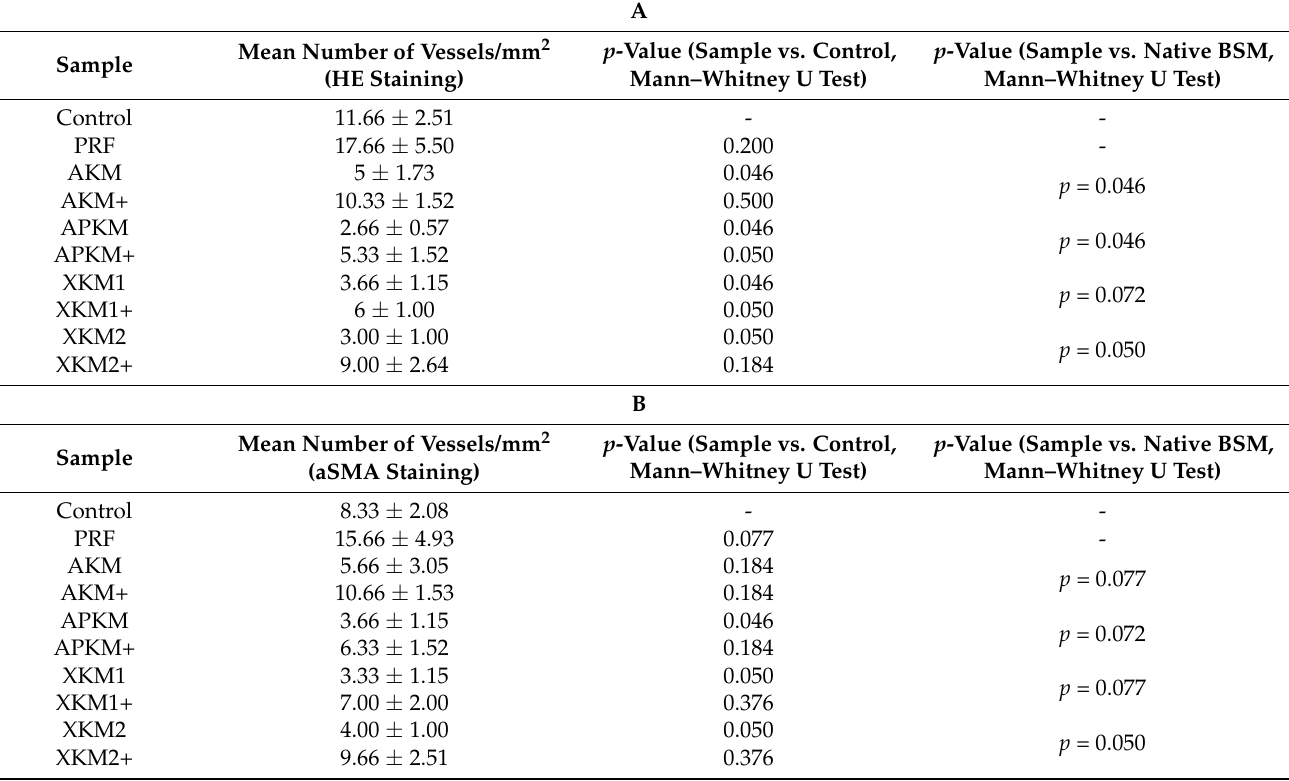
Table 4. Mean vessels/mm 2 after HE staining ( A ) and aSMA staining ( B ) after 24 h of incubation of each sample within the CAM assay in comparison to the negative control and PRF alone, evaluated immune-histochemically. p -values are given for a comparison of each sample with the control and with their native BSM (Mann–Whitney U